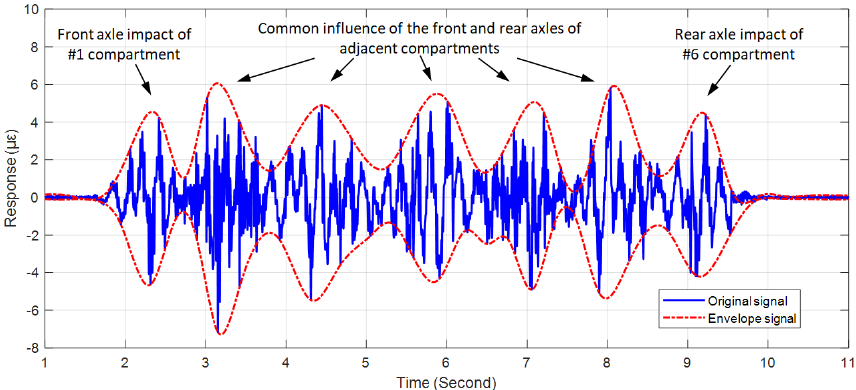
Figure 8. Original time series of vibration and corresponding envelopes during the passage of the train through one monitoring zone.